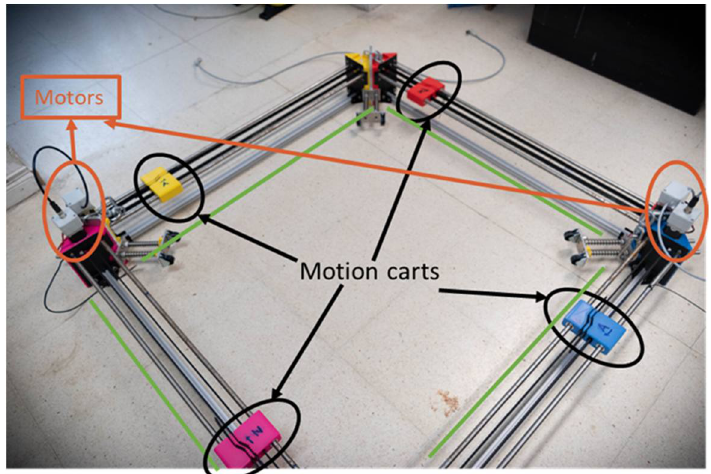
Figure 9. Mechanical system.